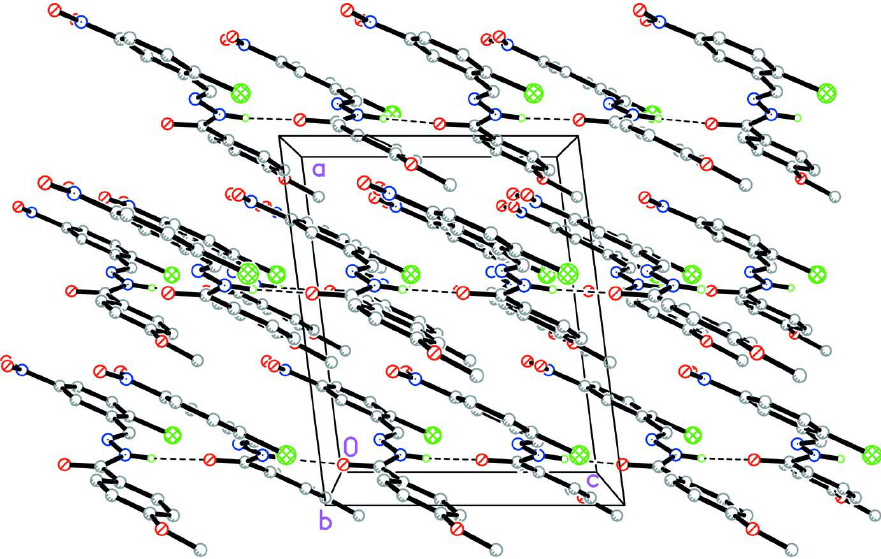
Figure 2 Packing diagram of the title compound, viewed along the b axis. Hydrogen bonds are shown as dashed lines. Hydrogen atoms not involved in hydrogen bonds are omitted for